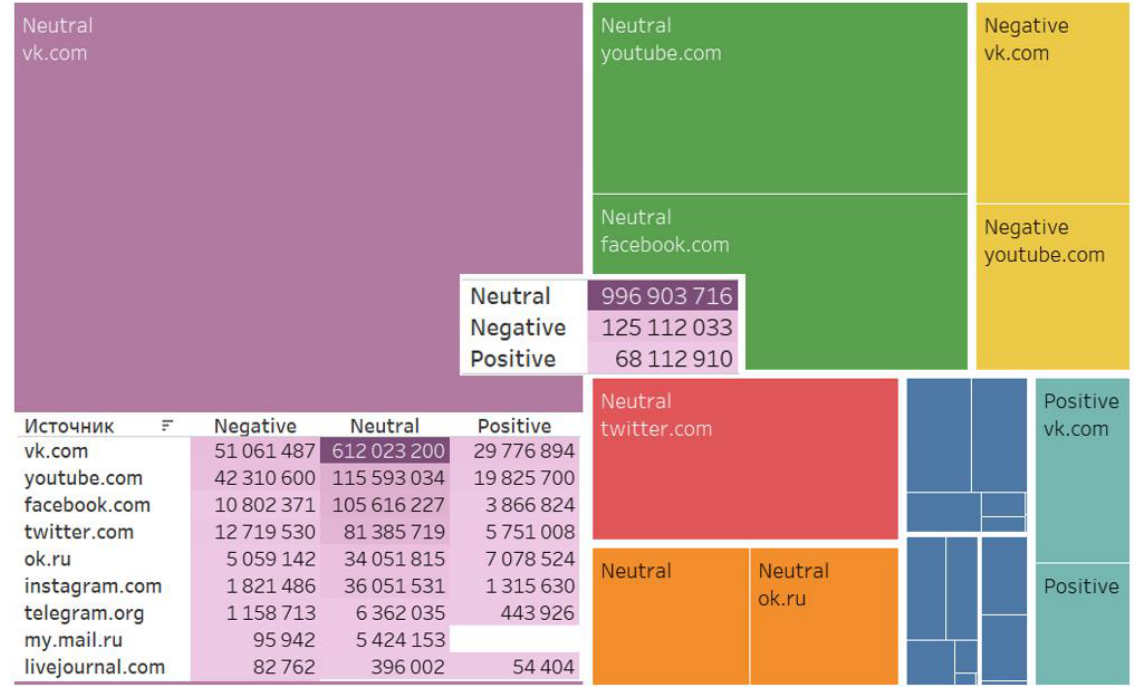
Figure 6. Sentiments of the content.